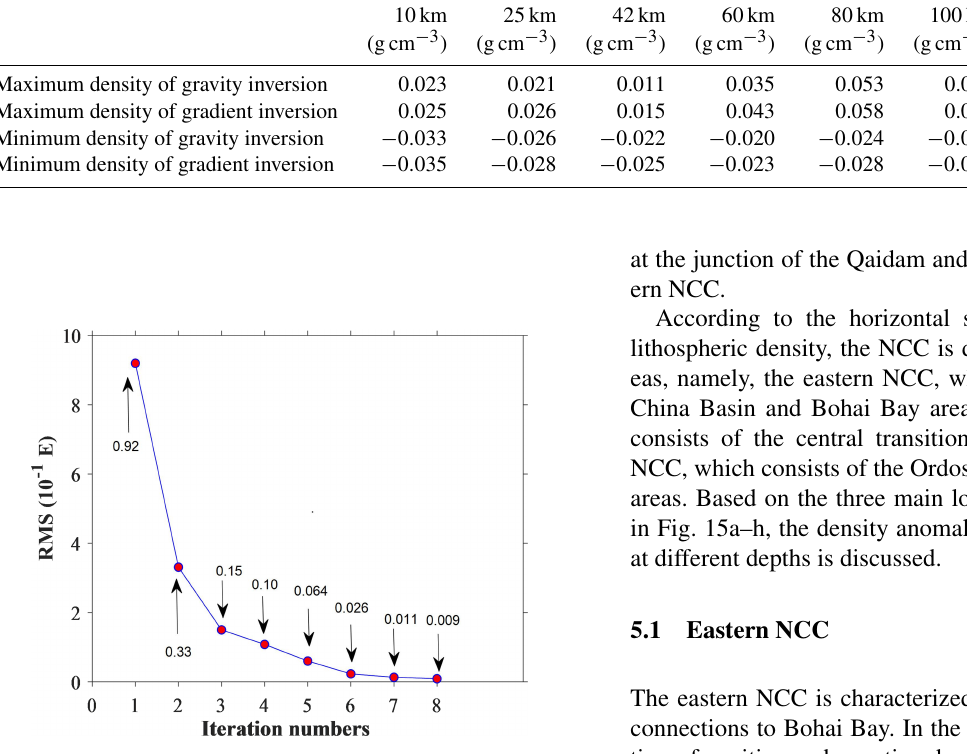
Figure 14. For the iterative calculation, the residual mean square between the forward-calculated theoretical gravity gradient and the gravity gradient measurements versus the iteration number in the PCG inversion